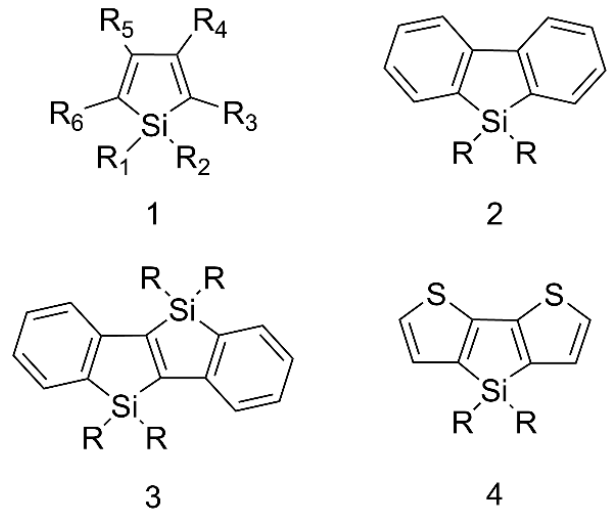
Figure 2. The representative types of siloles.